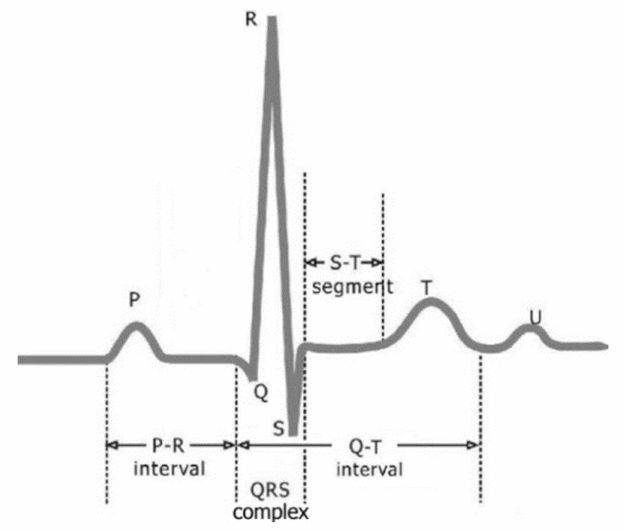
Figure 1. The electrocardiogram (ECG) of a heart in a normal sinus